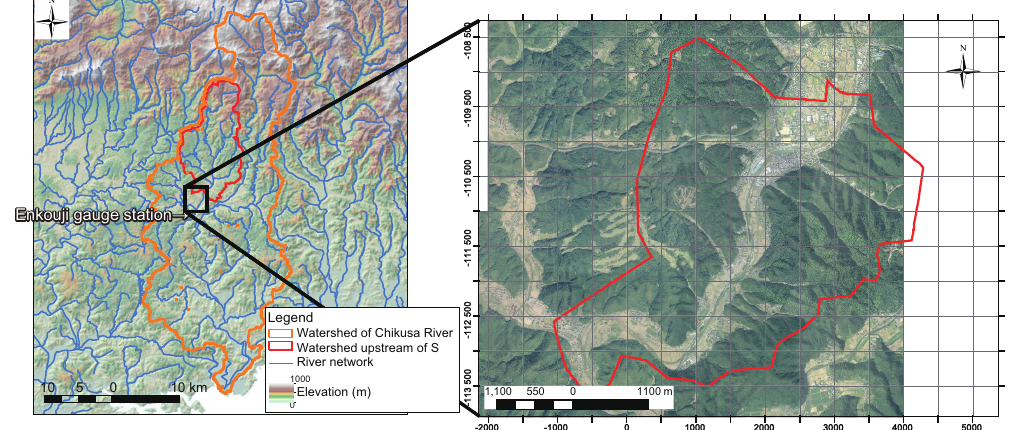
Figure 5. Watershed of Chikusa River (left) and hydraulic flood model domain in section S of Sayo River (right). (Source: National Land Numerical Information download service, Ministry of Land, Infrastructure, Transport and Tourism, Japan, for digital elevation model, wa- tersheds, and river network and Kinki Regional Development Bureau, Ministry of Land, Infrastructure, Transport and Tourism Japan for the aerial photo taken in 2010.)